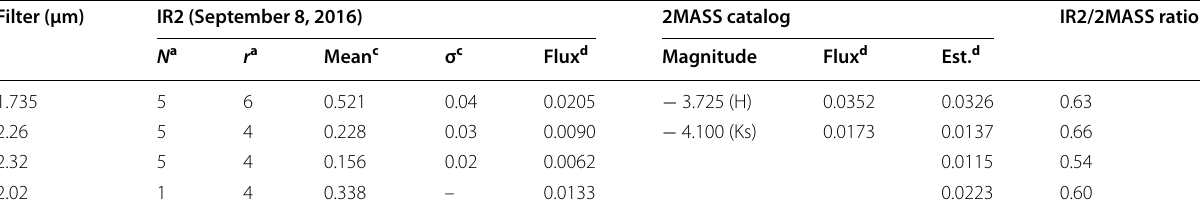
H-band of 2MASS is 1.662 (μm), and Ks-band is 2.159 (μm) a Number of Antares images with the filter a Radius of aperture used in photometry (pixels)